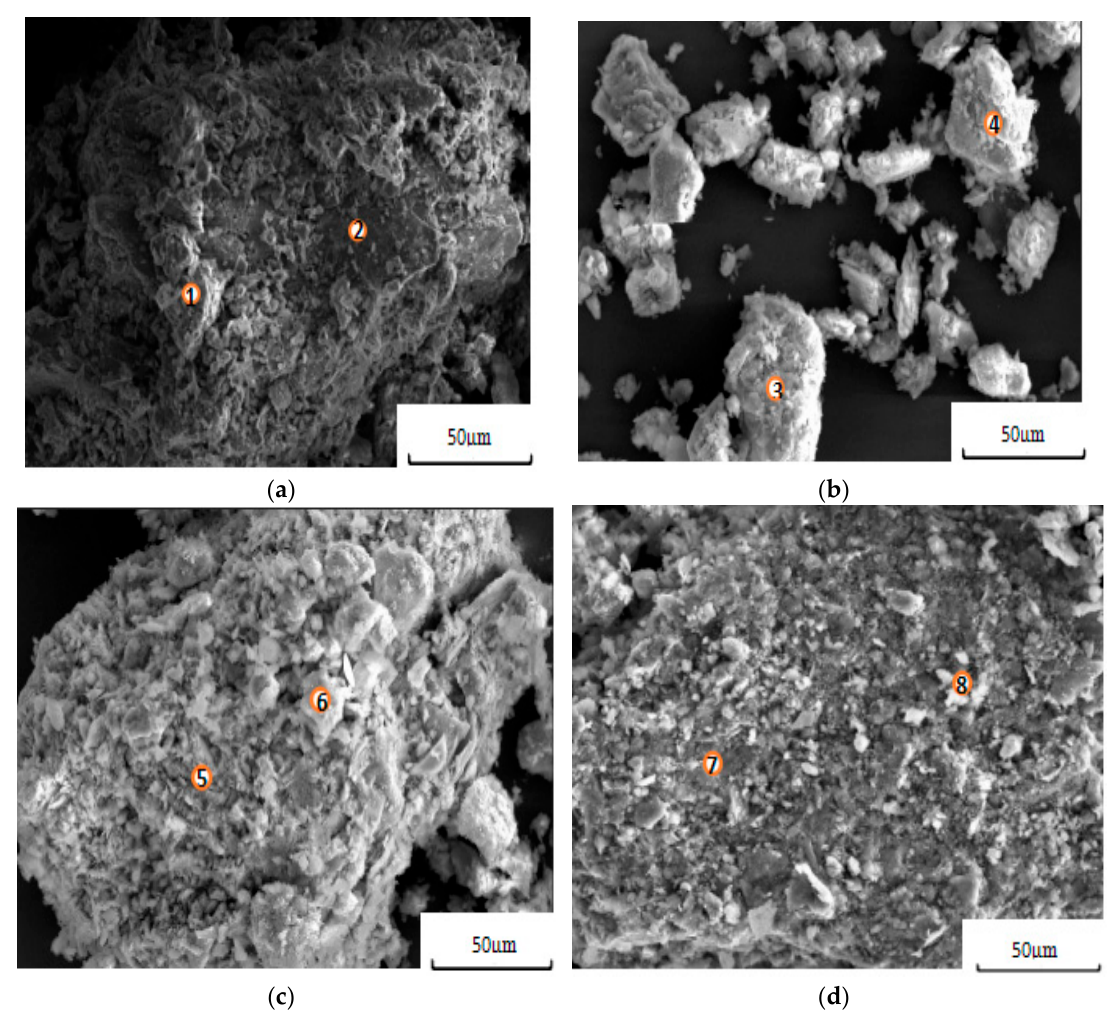
Figure 3. SEM images of coal gangues. ( a ) Raw-CG sample; ( b ) pH = 4.5-CG; ( c ) pH = 7.2-CG; ( d ) pH = 8.5-CG.